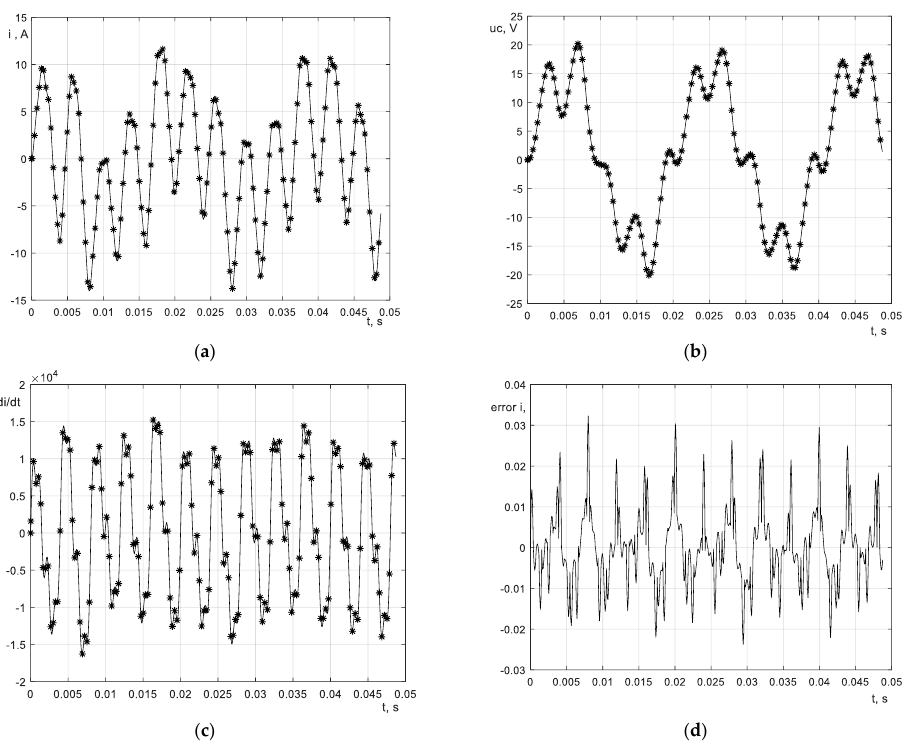
Figure 4. Results of transient calculation; ( a ) current, ( b ) voltage across condenser; ( c ) current derivative; ( d ) deviations of current function values error i